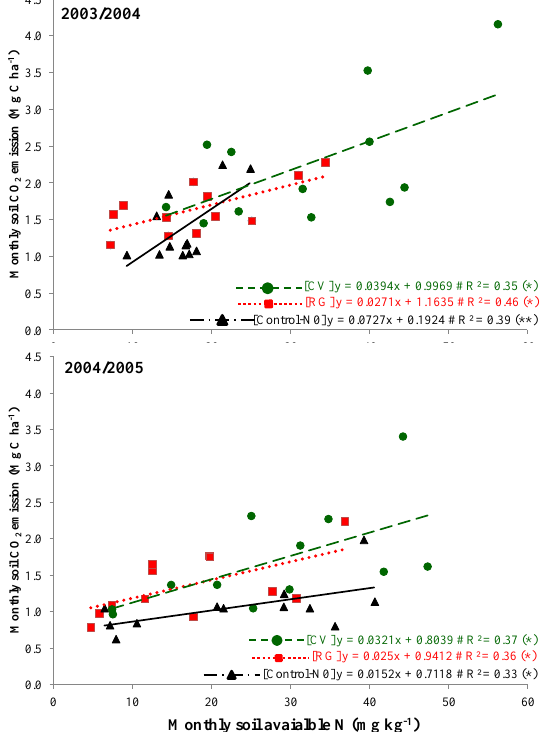
Figure 3. Soil available N plotted against soil CO 2 emission for each month of two years in common vetch (CV), ryegrass (RG), and unfertilized control (Control-N0). The data fit with linear regression models. The significance level is (*) or (**) at P < 0.05 or P < 0.01, respectively.